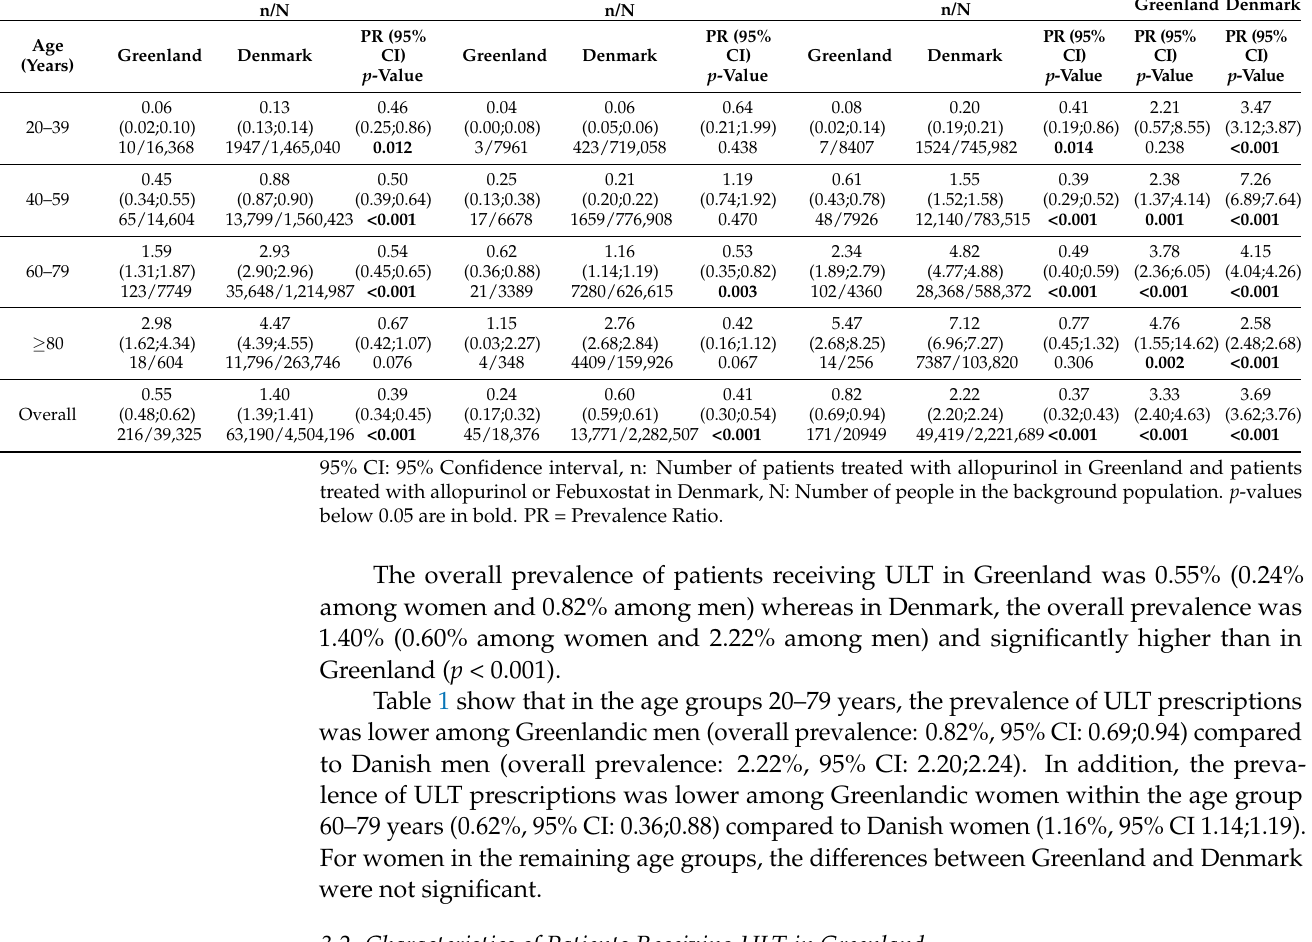
Men Prevalence (95% CI) n/N